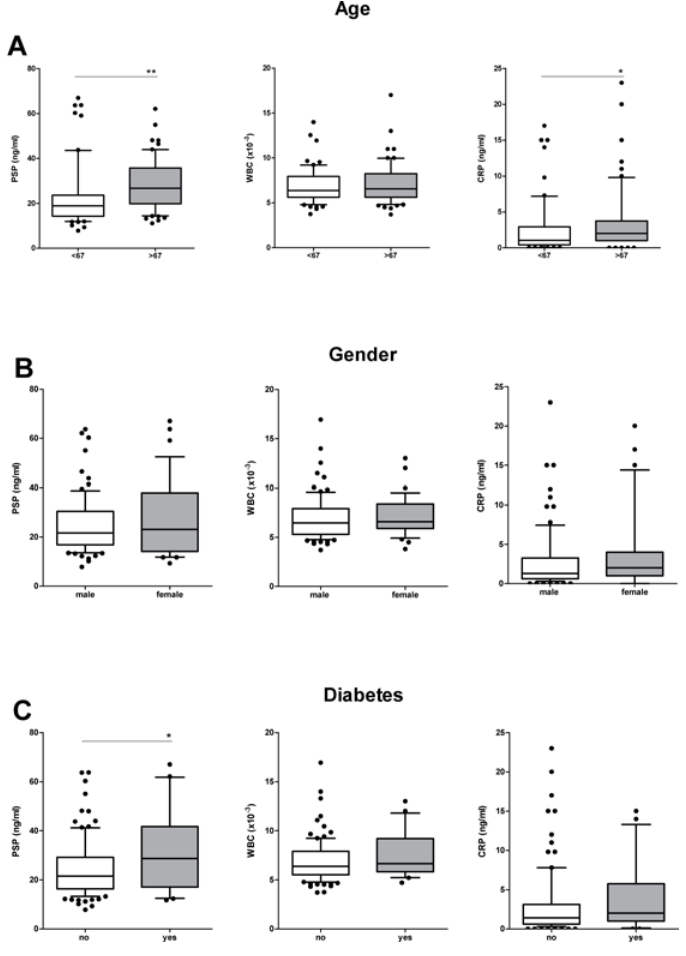
Fig 1. Association of PSP, CRP and WBC levels with age (A), gender (B) and diabetes (C). Shown are values at baseline (preoperative values). The groups were compared by one-way ANOVA. Asterisks indicate significant differences ( * p < 0.05; ** p <